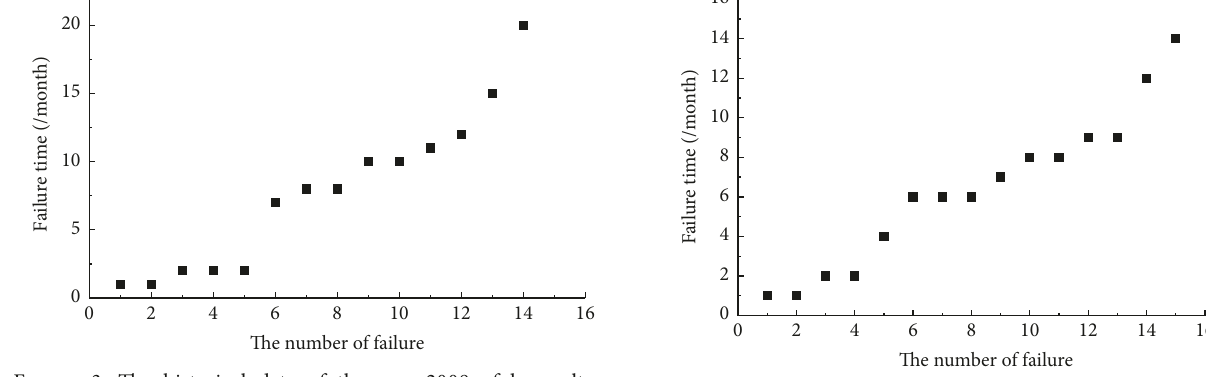
Figure 3: The historical data of the year 2008 of low-voltage switchgear.